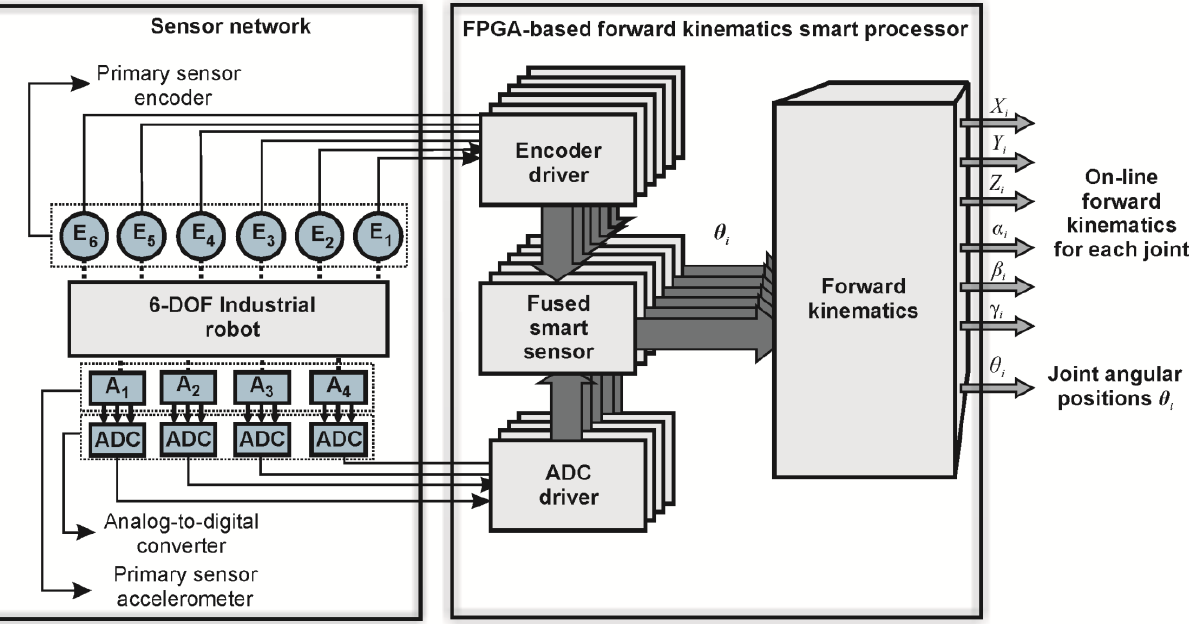
Figure 3. Sensor network and the FPGA-based forward kinematics smart